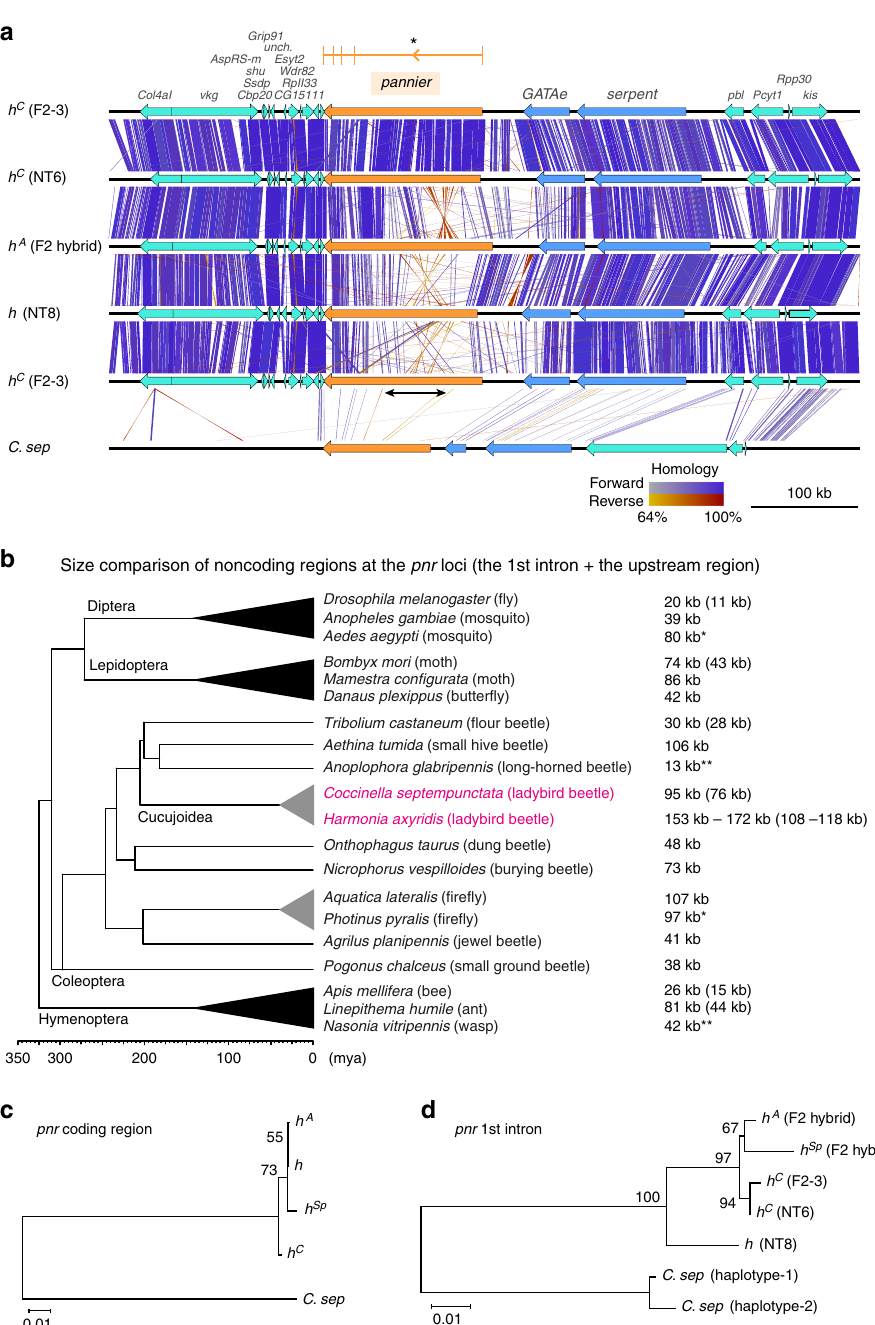
Fig. 5 Traces of inversions and high sequence diversi fi cation within a pannier intron in ladybird beetles. a Sequence comparison of the genomic region surrounding the pannier locus. 700 kb genomic sequences surrounding the pannier locus were extracted from the genome assembly of each allele in H. axyridis ( h C , h A , h ) and C. septempunctata ( C. sep ). Strain names are given in parentheses. Arrows indicate genes predicted by the exonerate program (Orange, pannier ; Blue, GATA transcription factor genes paralogous to pannier ; Green, other genes). Gene names are listed at the top. Vertical or diagonal bars connecting adjacent genomic structures indicate BLAST 72 hit blocks (bluish, forward hit; reddish, reverse hit) in the comparison between the two adjacent genomic scaffolds. The colour code for colouring the bars is at the bottom. The exon − intron structure and the fi rst intron (*) of pannier (1A isoform) is depicted on the top of the panel. The upper half ( fi rst intron) of the pannier locus is diversi fi ed (whitish) between different h alleles in H. axyridis , and shows traces of inversions (crossed reddish bars). Several intronic sequences are conserved between H. axyridis and C. septempunctata (bars located in the upper half of pannier in C. sep ). The black arrow indicates the region speci fi cally expanded in H. axyridis . b Overview of the size of the upper noncoding regions (the fi rst intron + the upper intergenic region) at the pannier ( pnr ) locus in holometabolous insects. The topology of the phylogenetic tree of surveyed insects is adapted from ref. 107 (Coleoptera), and TIMETREE 108 (Diptera, Hymenoptera, Lepidoptera). The sizes of the fi rst introns are given in parenthesis if cDNA information was available. H. axyridis has the largest noncoding sequence at the pannier locus. In some species, synteny of the three paralogous GATA genes was broken up by translocation (*) or insertion (**). c , d ML phylogenetic trees constructed with nucleotide sequences of pannier ( pnr ) coding region ( c ), and those of the conserved region in the fi rst intron ( d ). The trees were drawn to scale with branch lengths measured in the number of substitutions per site. Bootstrap values were calculated from 1000 resampling of the alignment data. Bars, 0.01